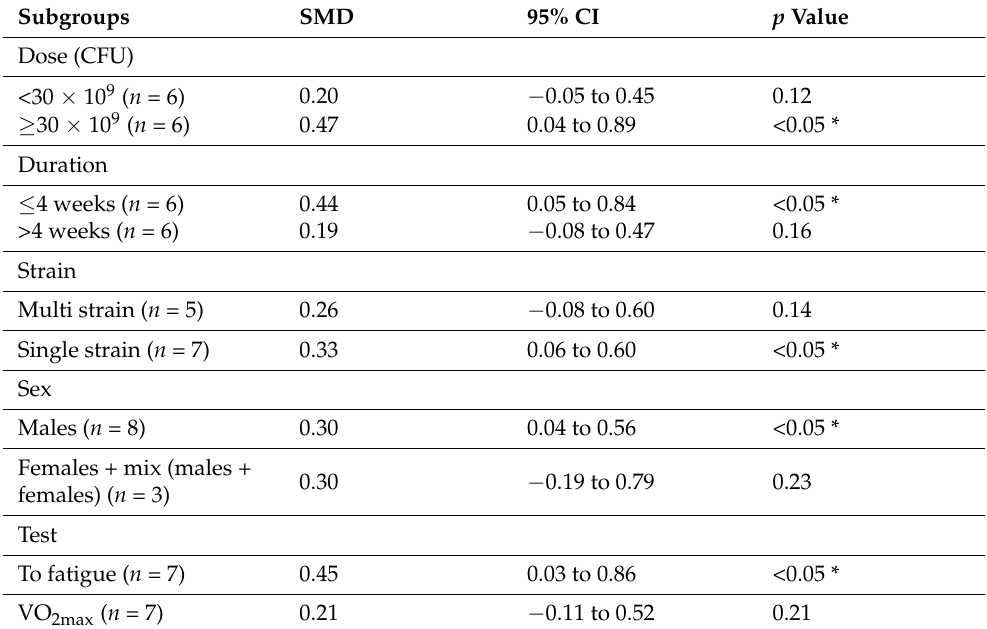
Table 6. Different characteristics of studies included in the meta-analysis regarding probiotic effects on exercise with aerobic metabolism